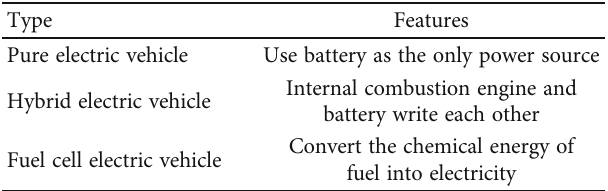
Table 1: Characteristics of three types of electric vehicles. Type